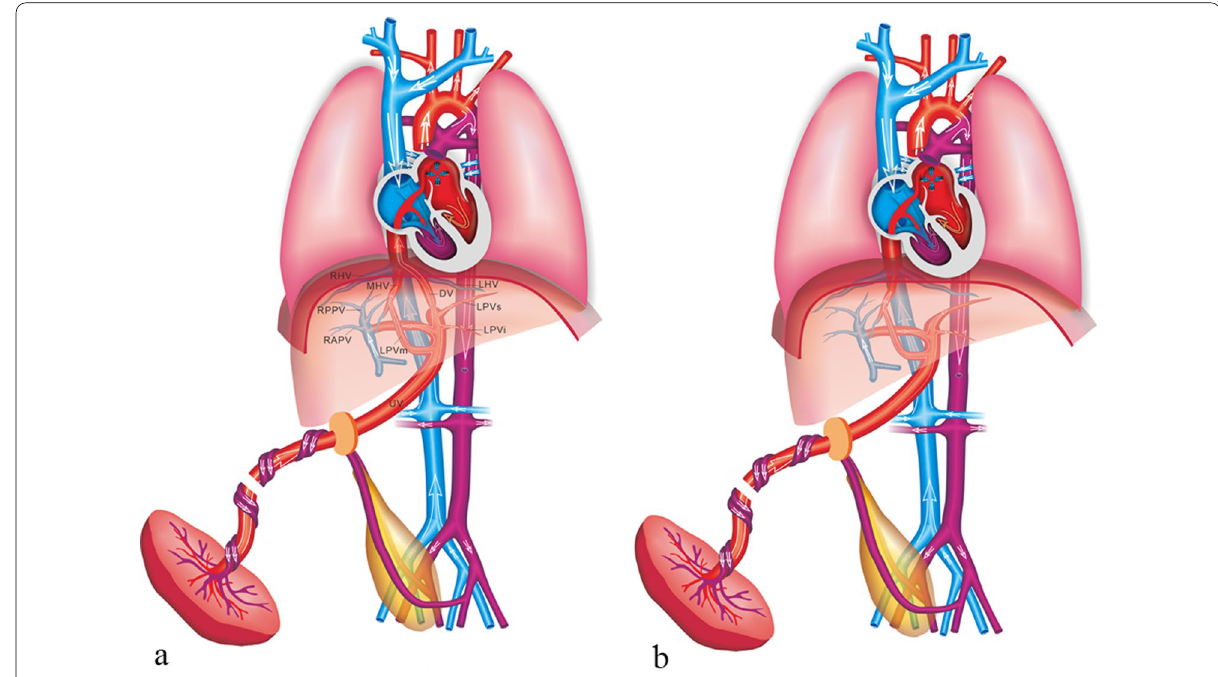
Fig. 12 Schematic drawing of the IHPSS with the DV presence ( a ) and absence ( b